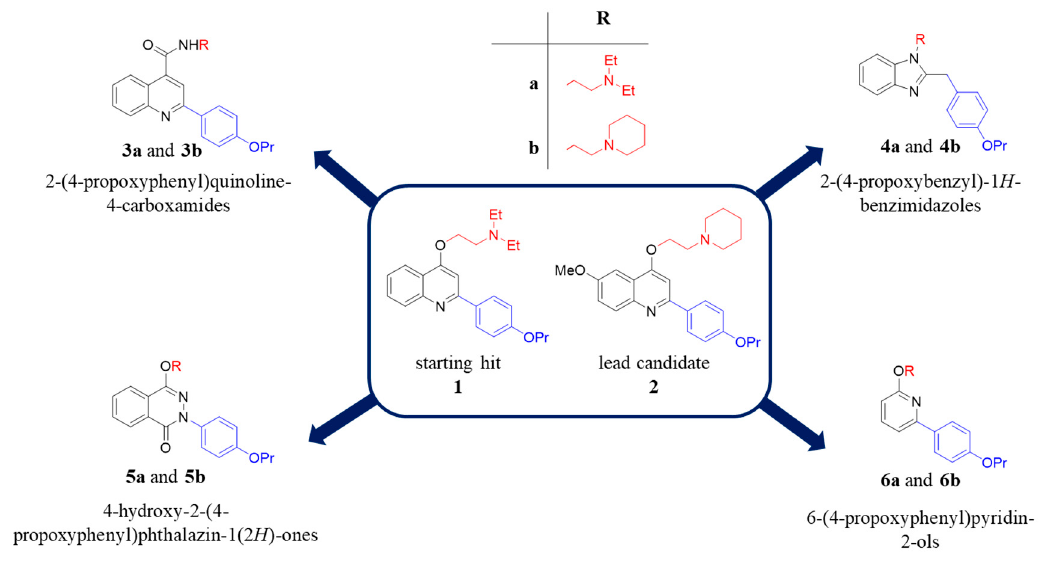
Figure 1. Chemical structures of the starting hit 1 and the lead candidate 2 and new synthesized compounds emerged from the in silico scaffold hopping approach.